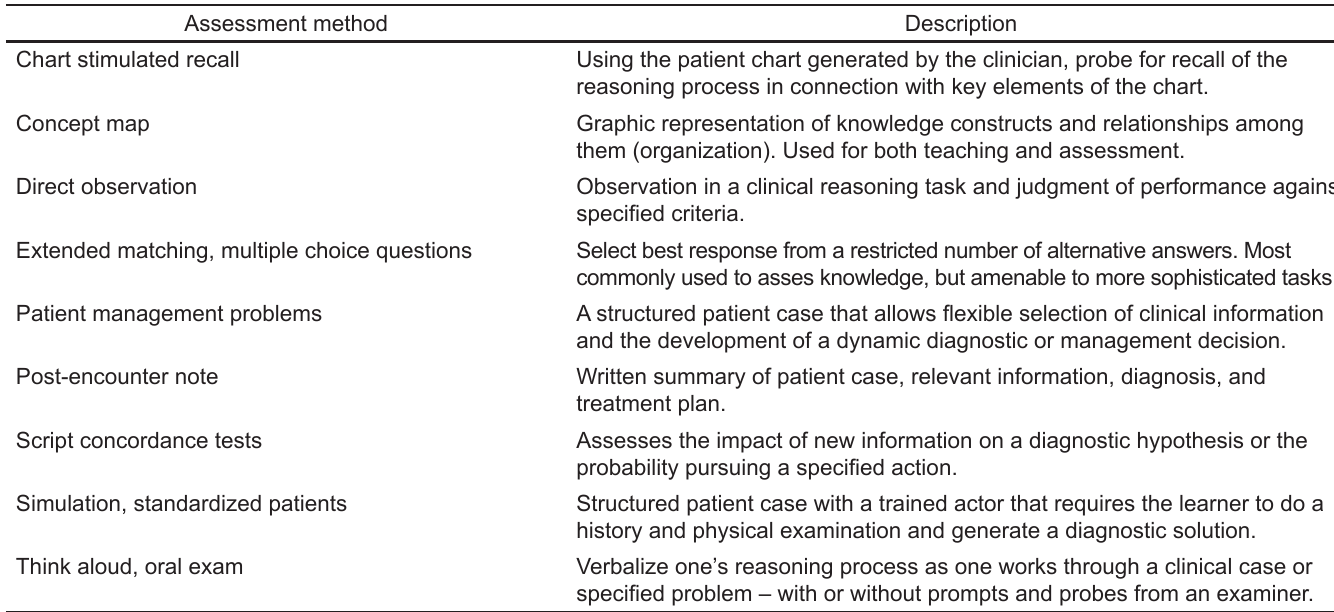
Table. Methods of assessing clinical